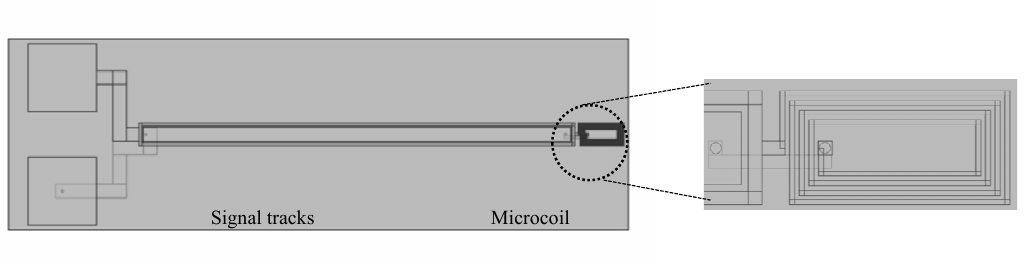
Figure 1. Microcoil design.